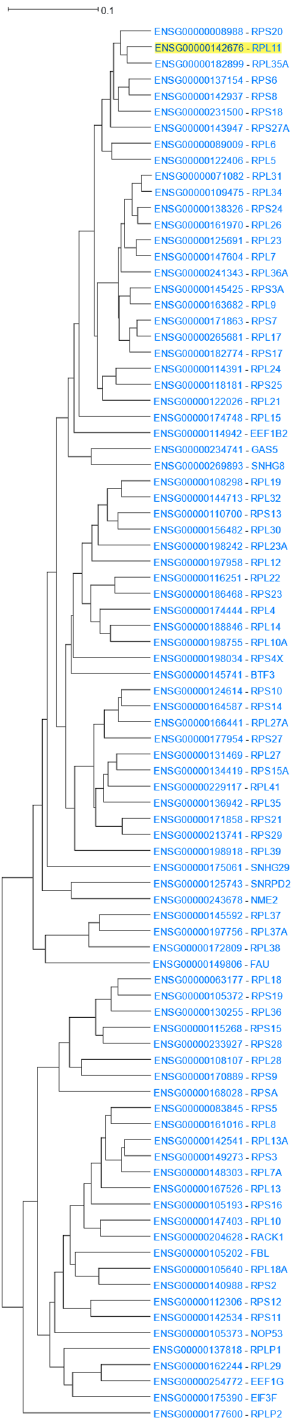
Figure 2. RPL11 14 internal node HGCA2.0 coexpression clade.